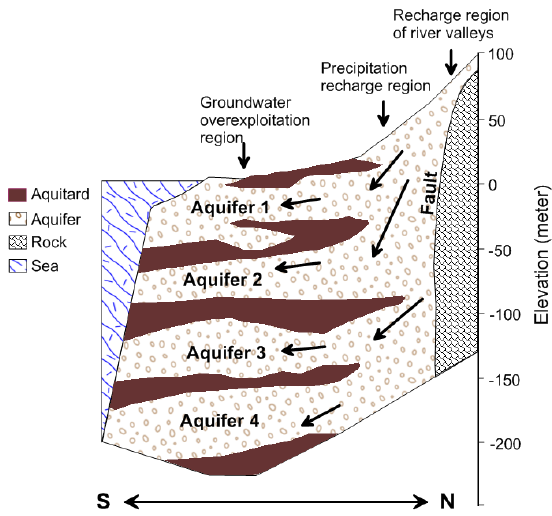
Figure 3. Hydrogeological profile of the study area.